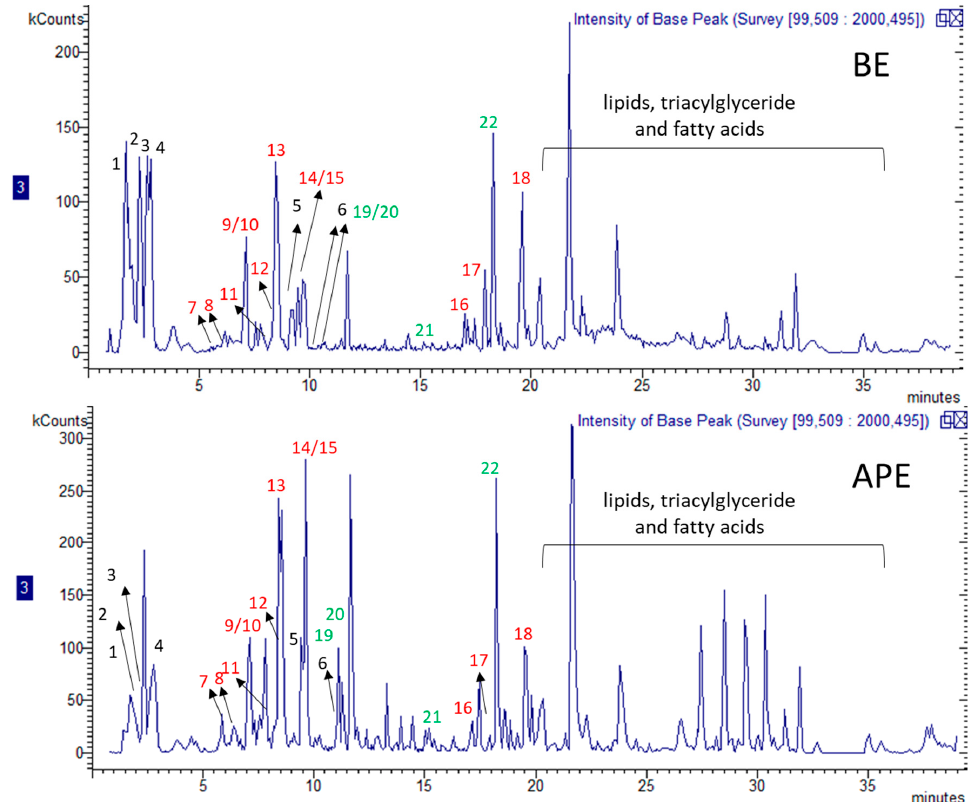
Figure 1. Chromatogram of BE and APE extract; number of compounds is related to Table 1: black = sulphur-containing compounds, red = flavonoid and phenol, green = amide phenylpropanoid derivatives.